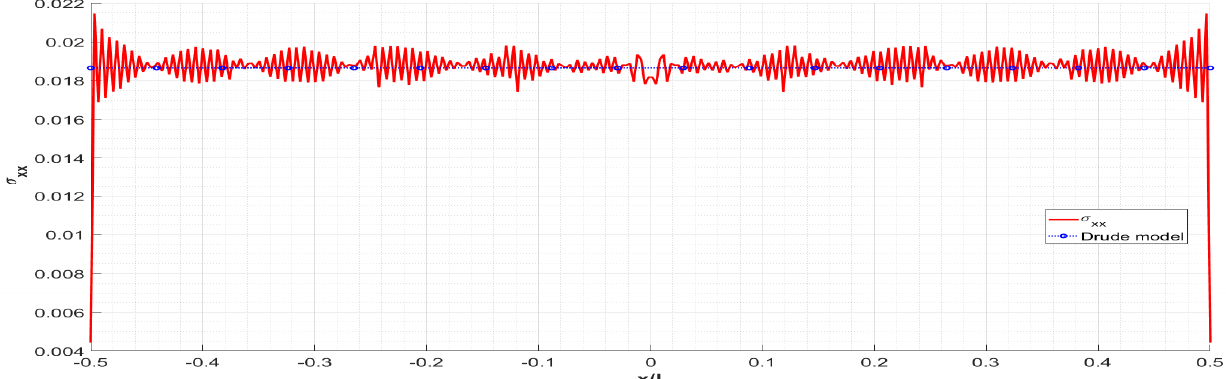
G Ll . L = 800 nm, μ = 1.0 Drude